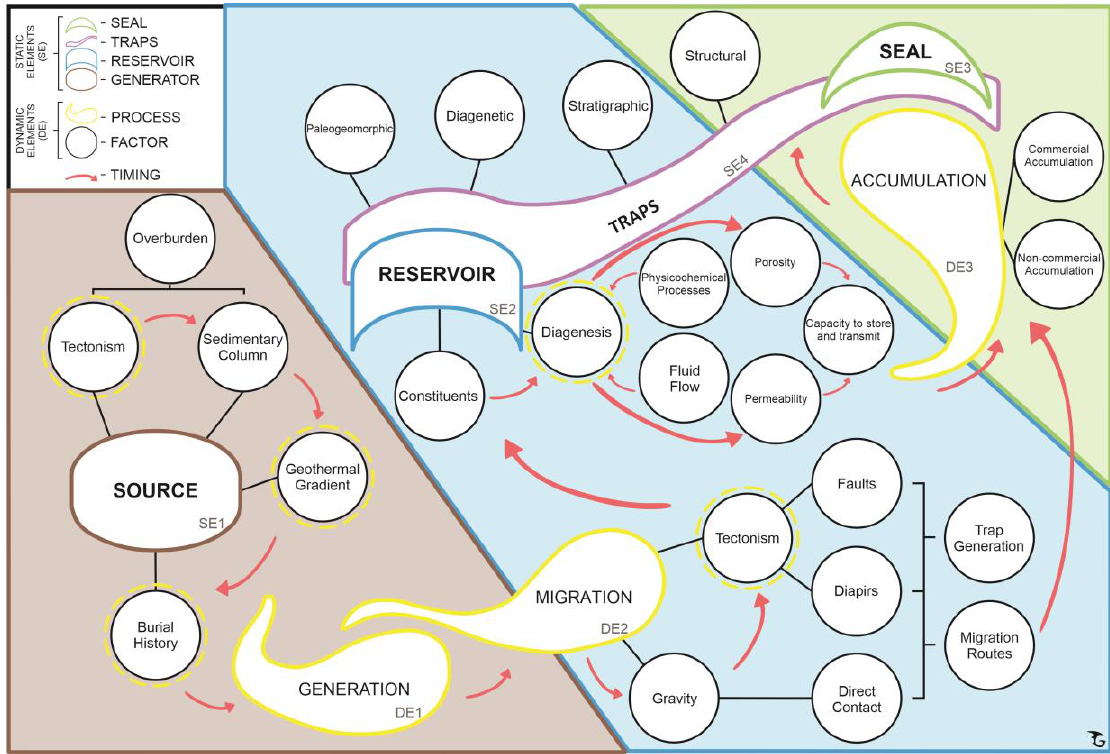
Figure 9. Illustrative diagram of the factors and processes (dynamic elements) that affect the static elements of a petroleum system. The graphic arrangement of these elements was performed according to their moment of contribution within the petroleum system